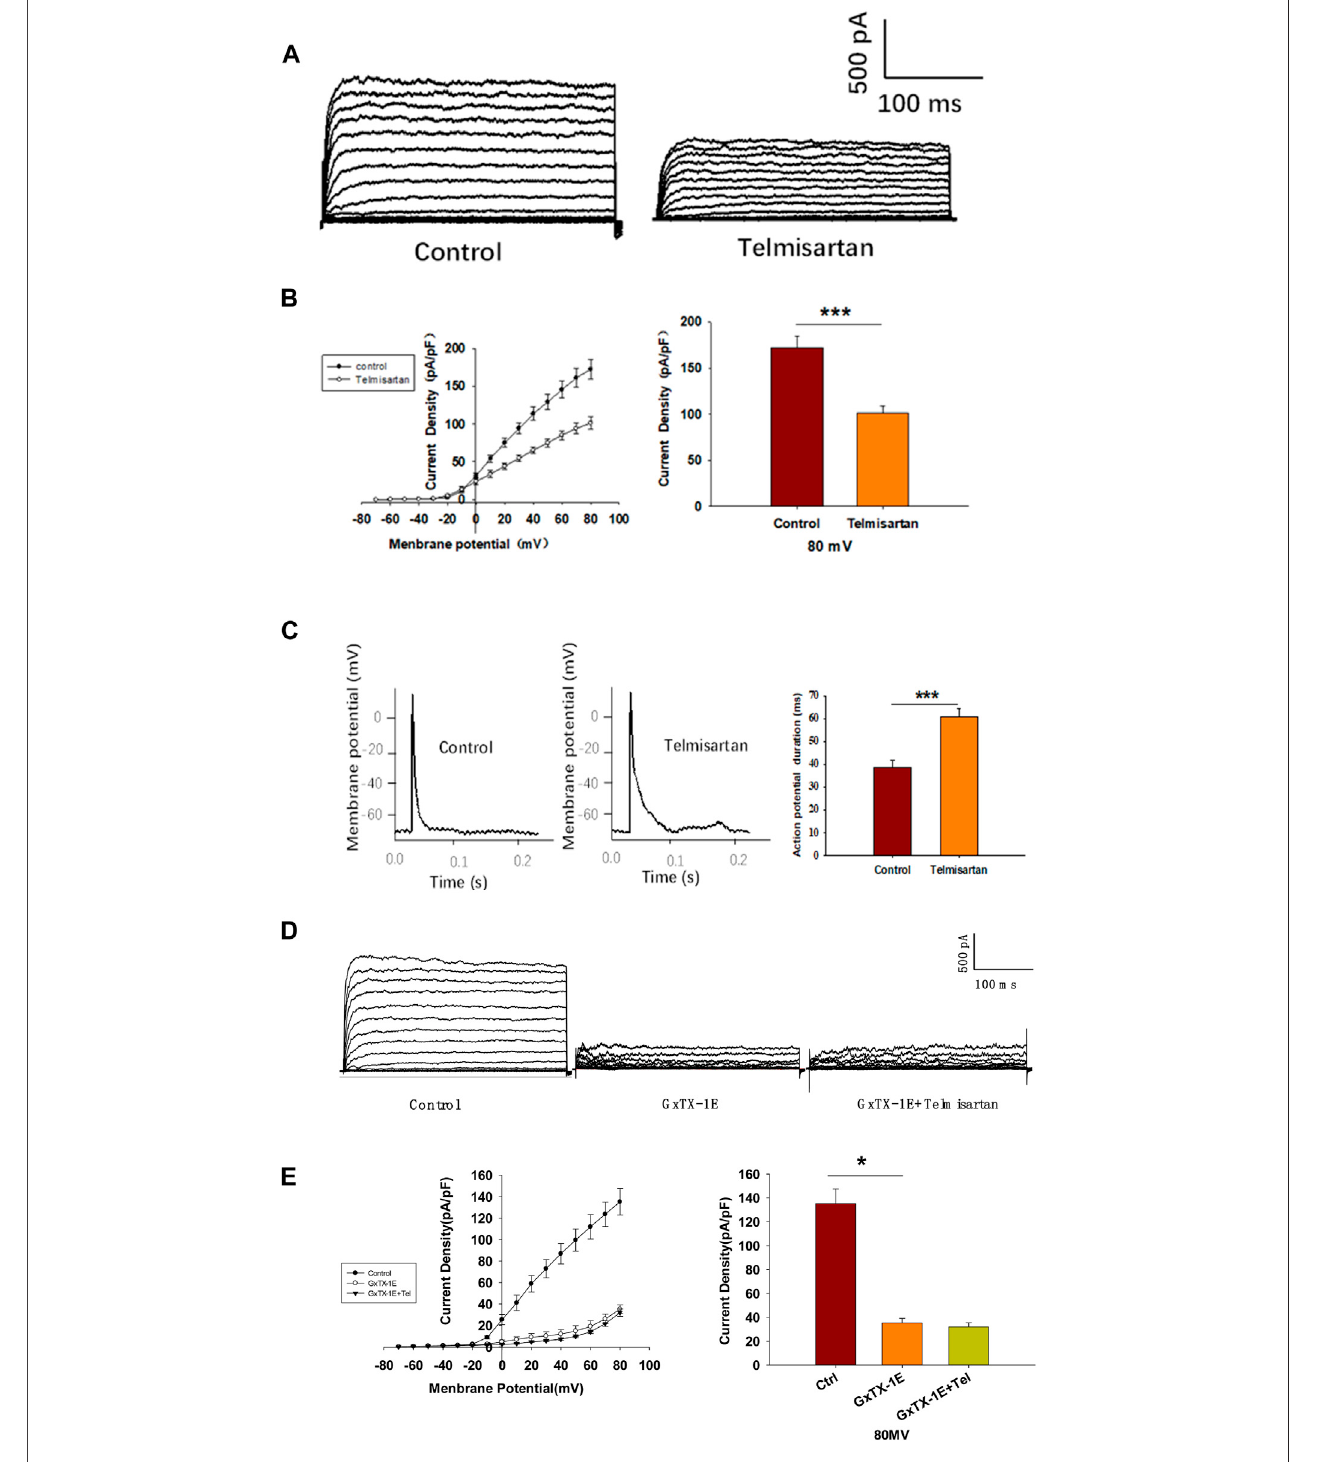
FIGURE 5 | Pancreatic β -cells treated with telmisartan exhibit reduced Kv currents and extended APD. (A) Kvcurrents were recorded in voltage-clamp mode with holding potential from − 70 to +80 mV in 10 mV increments. Representative current traces recorded in control and telmisartan-treated (10 μ M) β -cells. (B) Current- voltagerelationshipcurvesofKvchannelsandsummaryofthemeancurrentdensityofKvchannelsrecordedat80 mVdepolarization(control n (cid:1) 9cells,telmisartan n (cid:1) 7 cells). (C) Action potentials were elicited by 4 ms, 150 pA current. Representative action potential waveforms for β -cells treated without or with telmisartan (10 μ M) and summary of the mean APDs ( n (cid:1) 7 cells). (D) Representative Kv current traces recorded under treatment of 100 nM Guangxitoxin-1E (GxTX-1E) alone or in